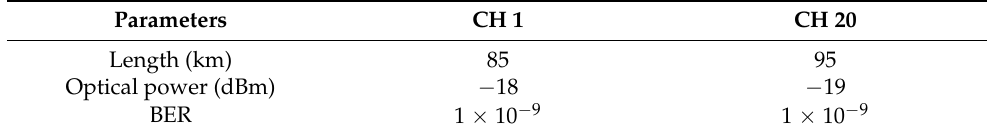
Table 2. Parameters and results of 40-channel DWDM system [20].